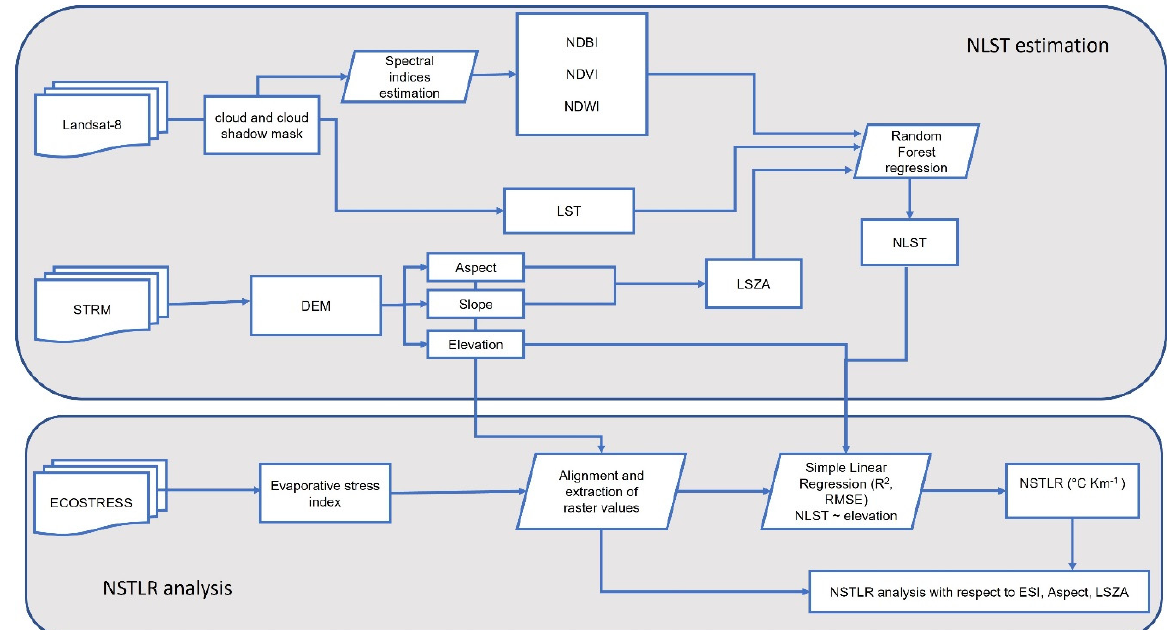
Figure 2. Flow diagram of data analysis.